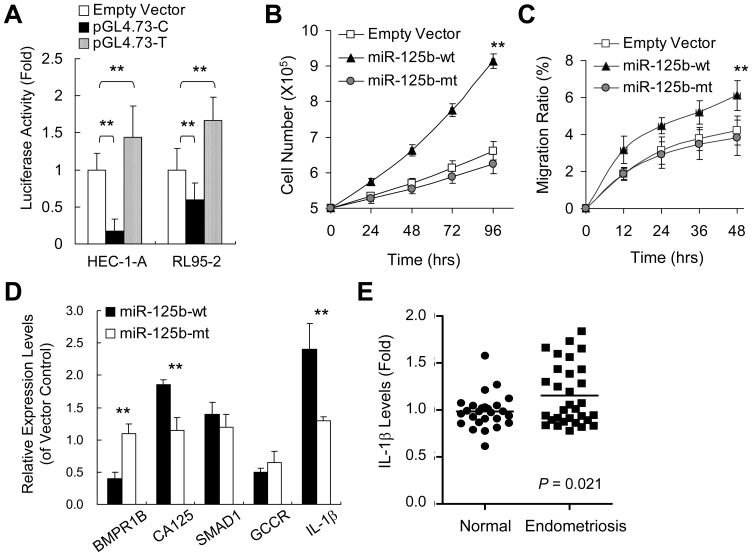
Variation disrupting recognition between miR-125b and 3′UTR of BMPR1B increases BMPR1B expression and inhibits abnormal cell growth in vitro.A. Luciferase reporter assay was employed to evaluate repression of BMPRIB in endometrial cell lines with C (HEC-1-A) or T (RL95-2) allele at rs1434536. Luciferase reporter pGL4.73 vectors, containing the reference C or variant T bearing sequence of BMPR1B 3′UTR, were transiently introduced into both cell lines. At 48h post-transfection, luciferase activities were measured and normalized to phosphatase activities. B. Cell growth of HEC-1-A cells transfected with empty vector or vector containing miR-125b-wt or miR-125b-mt with a mutated base complementary to the minor allele at rs1434536. At different time intervals, cells were counted using hemocytometer. C. HEC-1-A cells transfected with vectors containing miR-125b-wt or miR-125b-mt were counted and rated with reference to total positively transfected (GFP+) cells. D. Expression levels of known BMPR1B responsive genes were analyzed in HEC-1 cells transfected with miR-125b-wt or miR-125-mt constructs, using empty vector-treated cells as references. E. Expression levels of IL-1β in clinical samples were measured by quantitative PCR. Statistical significance is calculated by Student t-test: *, P<0.05; **, P<0.01.